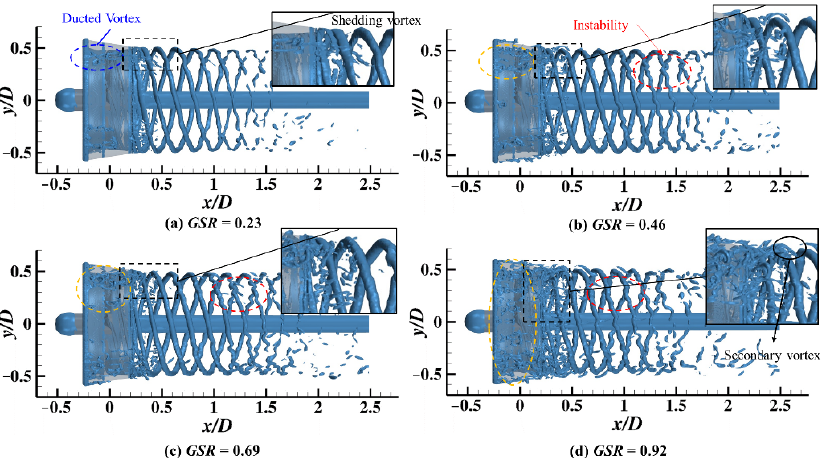
Figure 14. Result comparison of the tail vortex region of the ducted propeller with different GSRs.